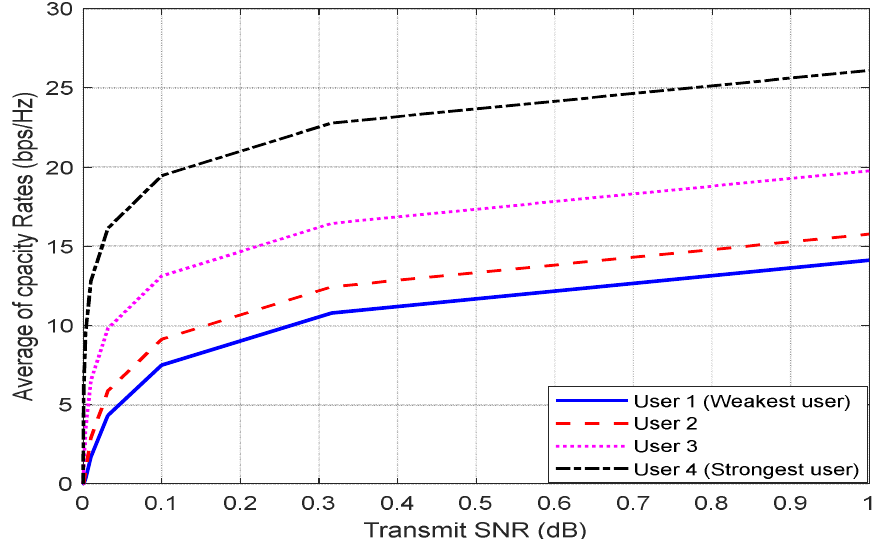
Figure 12. Average capacity rate against SNR for four users with varying distances and BW 200 MHz for UL NOMA.